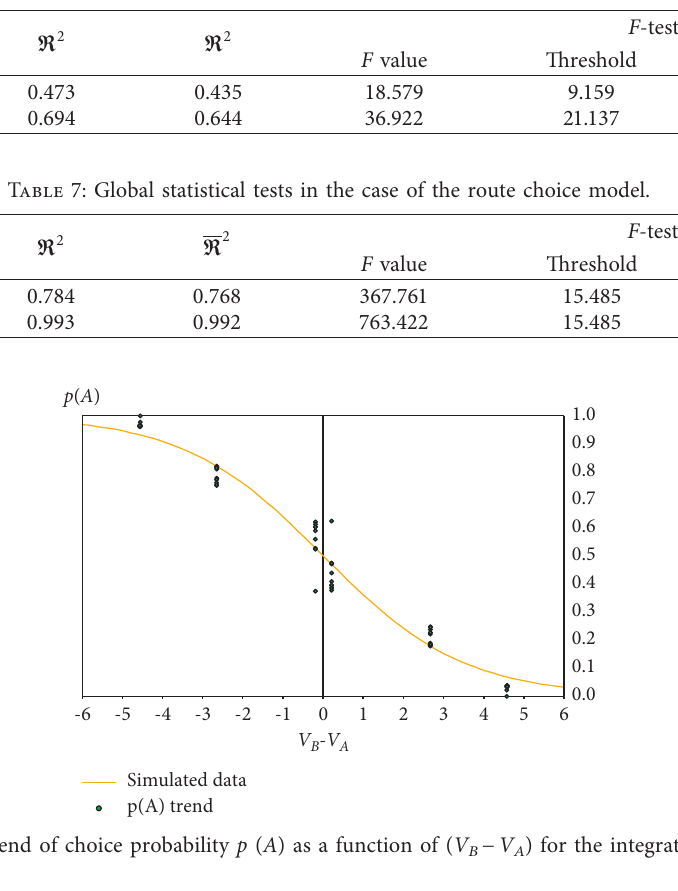
− V B A ) for the interfaceable